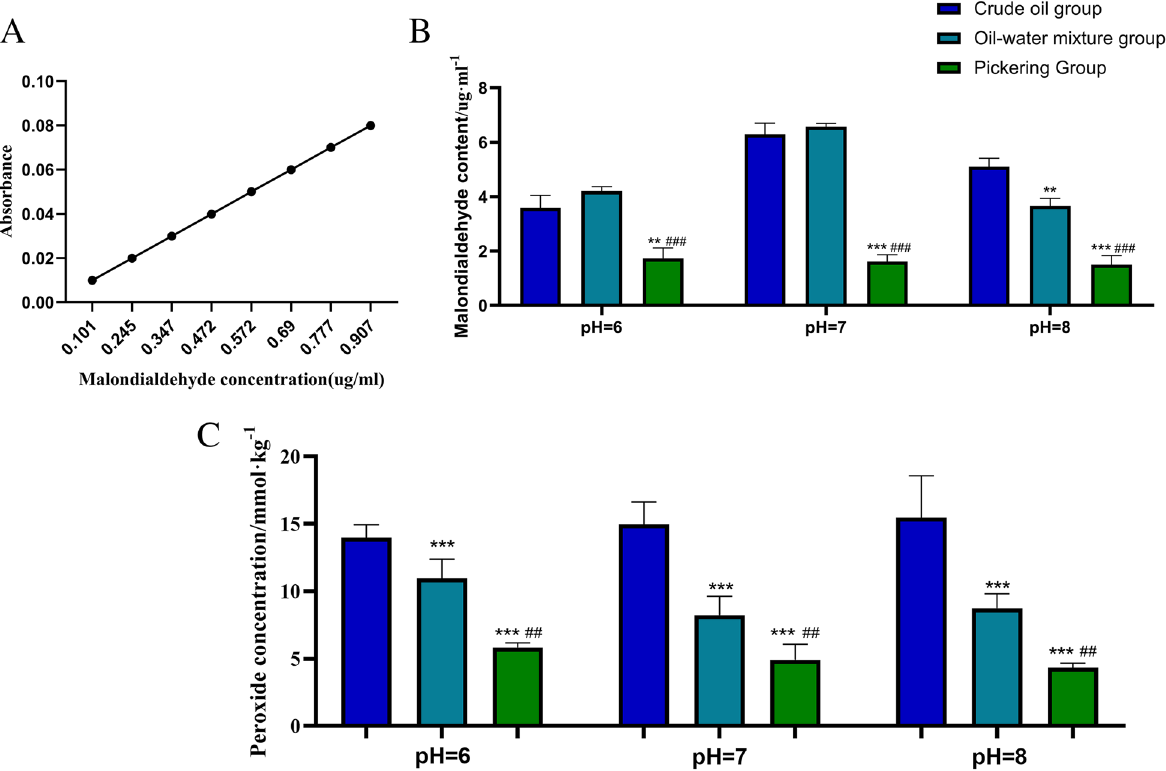
Fig. 3 Standard curve of malondialdehyde and absorbance and comparison of index changes among groups. A Standard curves of malondialdehyde concentration and absorbance. B Content of malondialdehyde at different time periods. C Content of peroxide at different time periods. Compared with the blank group * P < 0.05, ** P < 0.01, *** P < 0.001, compared with the oil‑water mixture group # P < 0.05, ## P < 0.01, ## P <